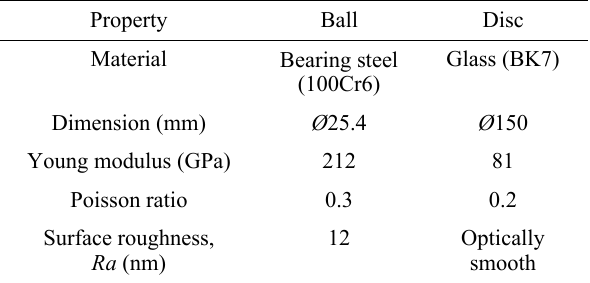
Table 2 Optical tribometer contacting tribopair material properties.